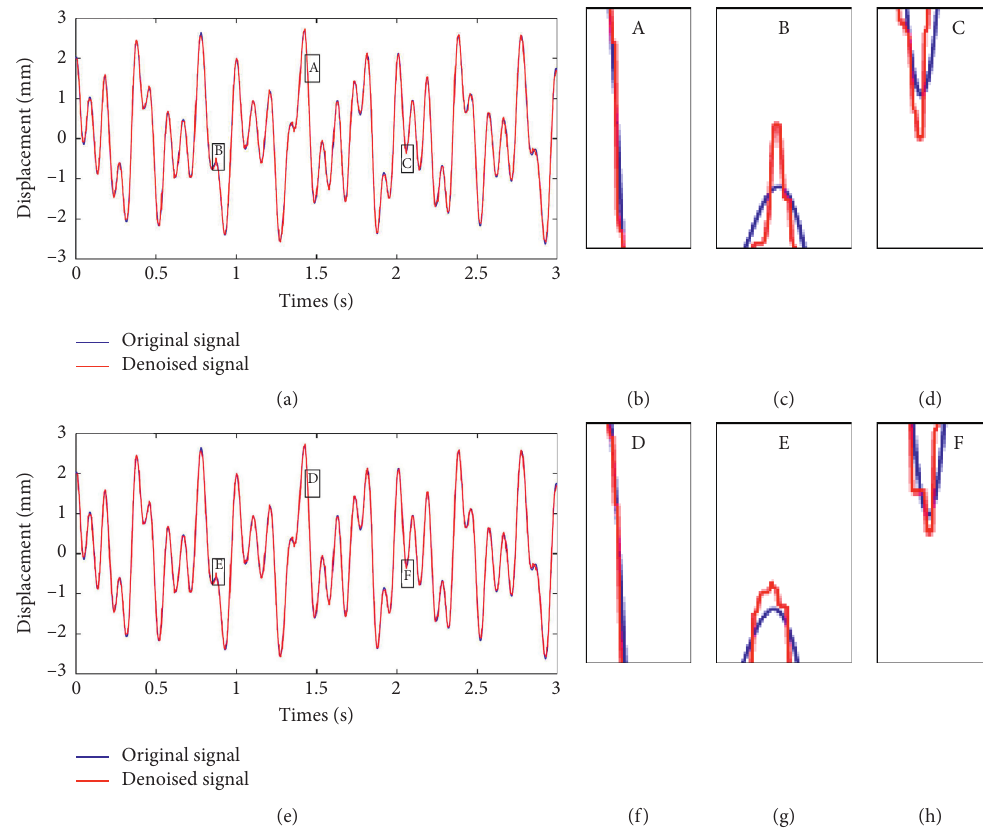
Figure 5: Curve comparison between the original signal X ( t ) and the denoised signal using the morphological filter and MF-EEMD methods. (a) Curve comparison between the original signal X ( t ) and the denoised signal using the morphological filter, (b) enlarged figure of area A in (a), (c) enlarged figure of area B in (a), (d) enlarged figure of area C in (a), (e) curve comparison between the original signal X ( t ) and the denoised signal using the MF-EEMD method, (f) enlarged figure of area D in (e), (g) enlarged figure of area E in (e), and (h) enlarged figure of area F in